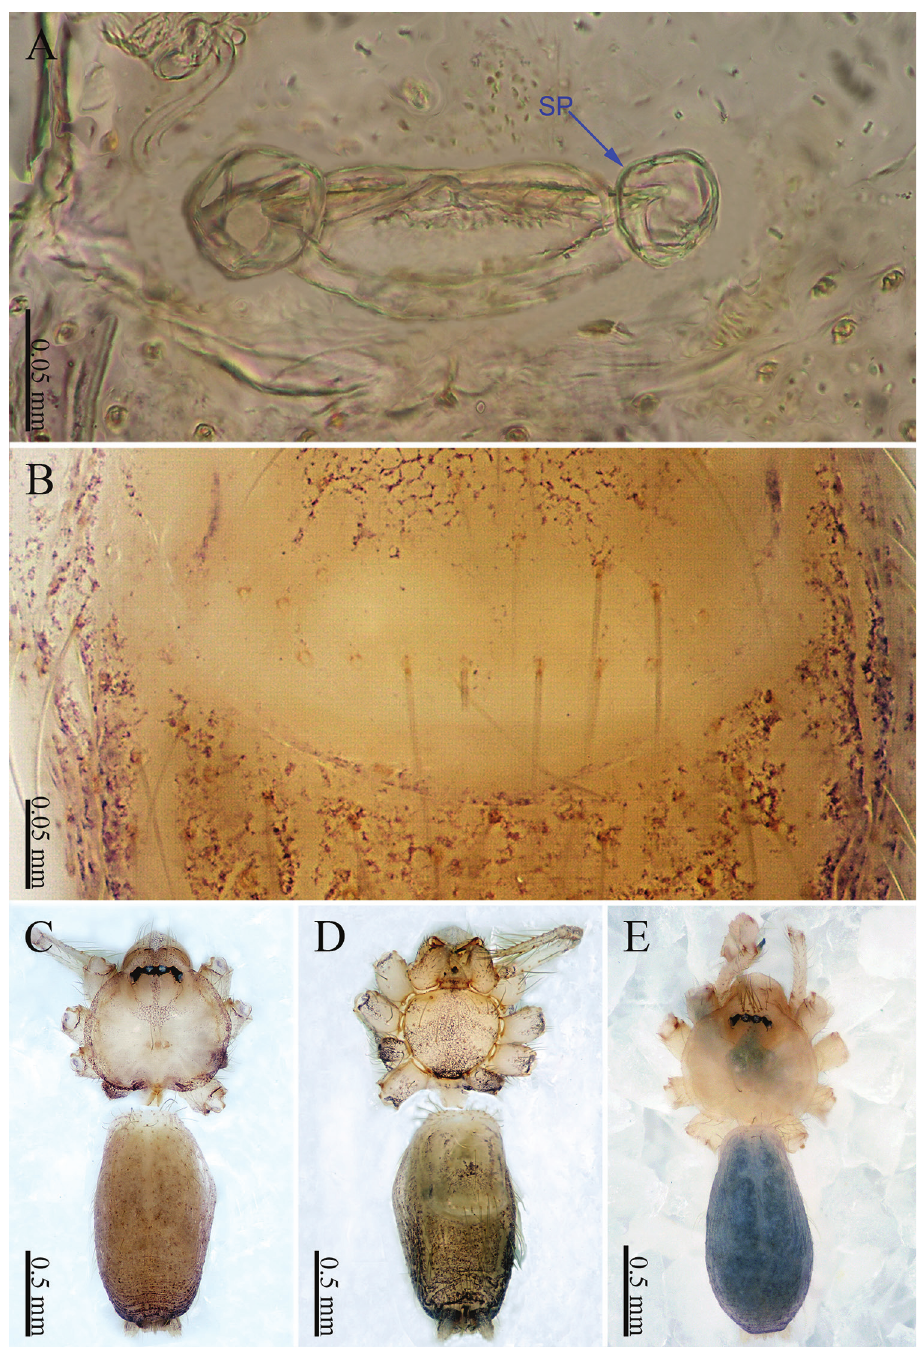
Figure 8. Sinoderces dewaroopensis Li & Li, sp. nov., male holotype and female paratype A internal geni- talia, dorsal view B female epigastric furrow, ventral view C female habitus, dorsal view D female habitus, ventral view E male habitus, dorsal view. Abbreviation: SP